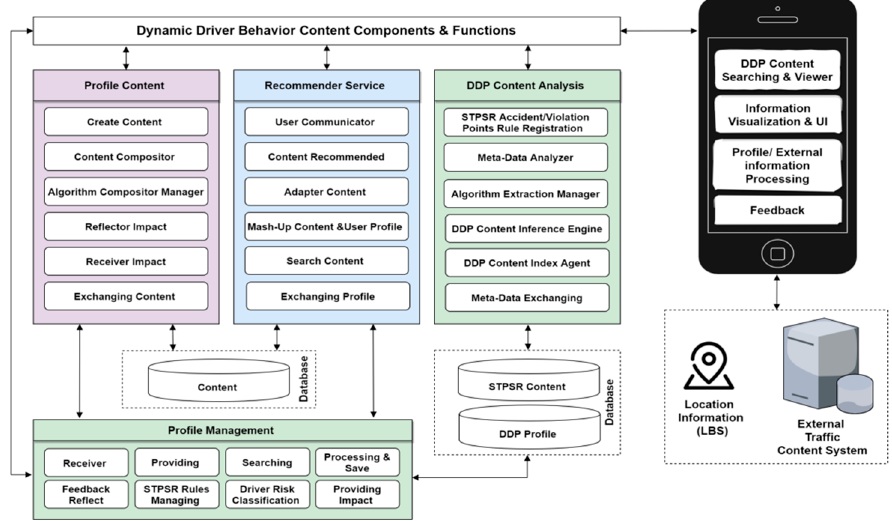
Figure 5. DDP components and functions.